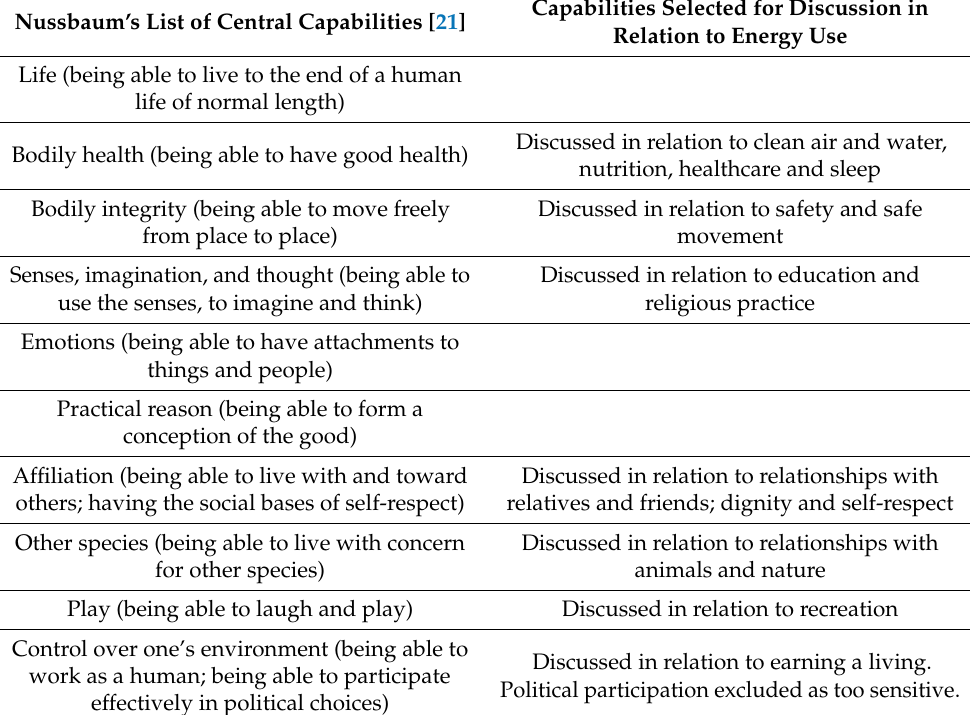
Table 1. Selection of basic capabilities for focus group